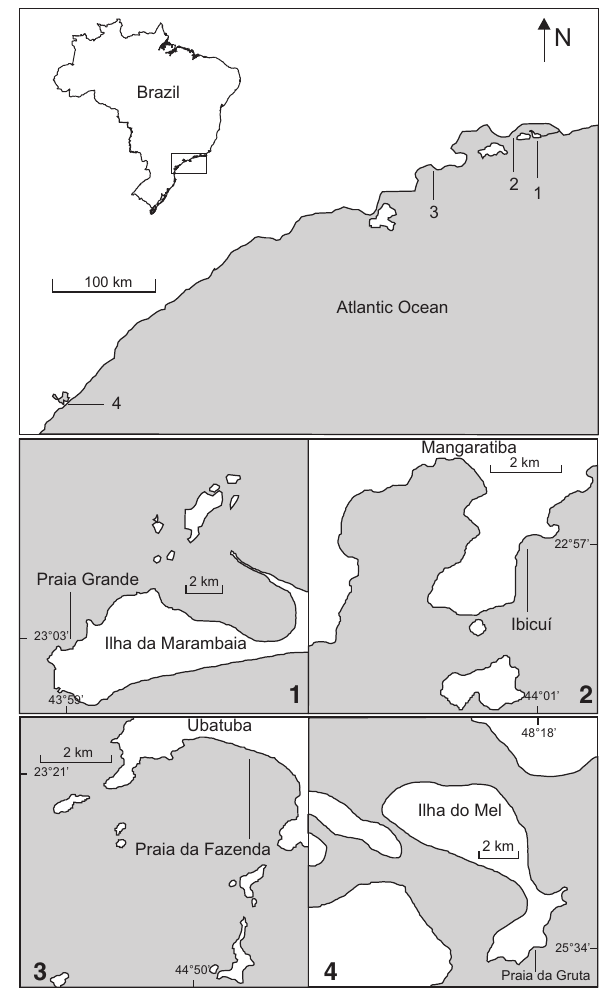
Figure 1. Location of the study area: (1) Praia Grande, Ilha da Marambaia, Rio de Janeiro State; (2) Ibicuí, Mangaratiba, Rio de Janeiro State; (3) Praia da Fazenda, Ubatuba, São Paulo State; (4) Praia da Gruta, Ilha do Mel, Paraná State.